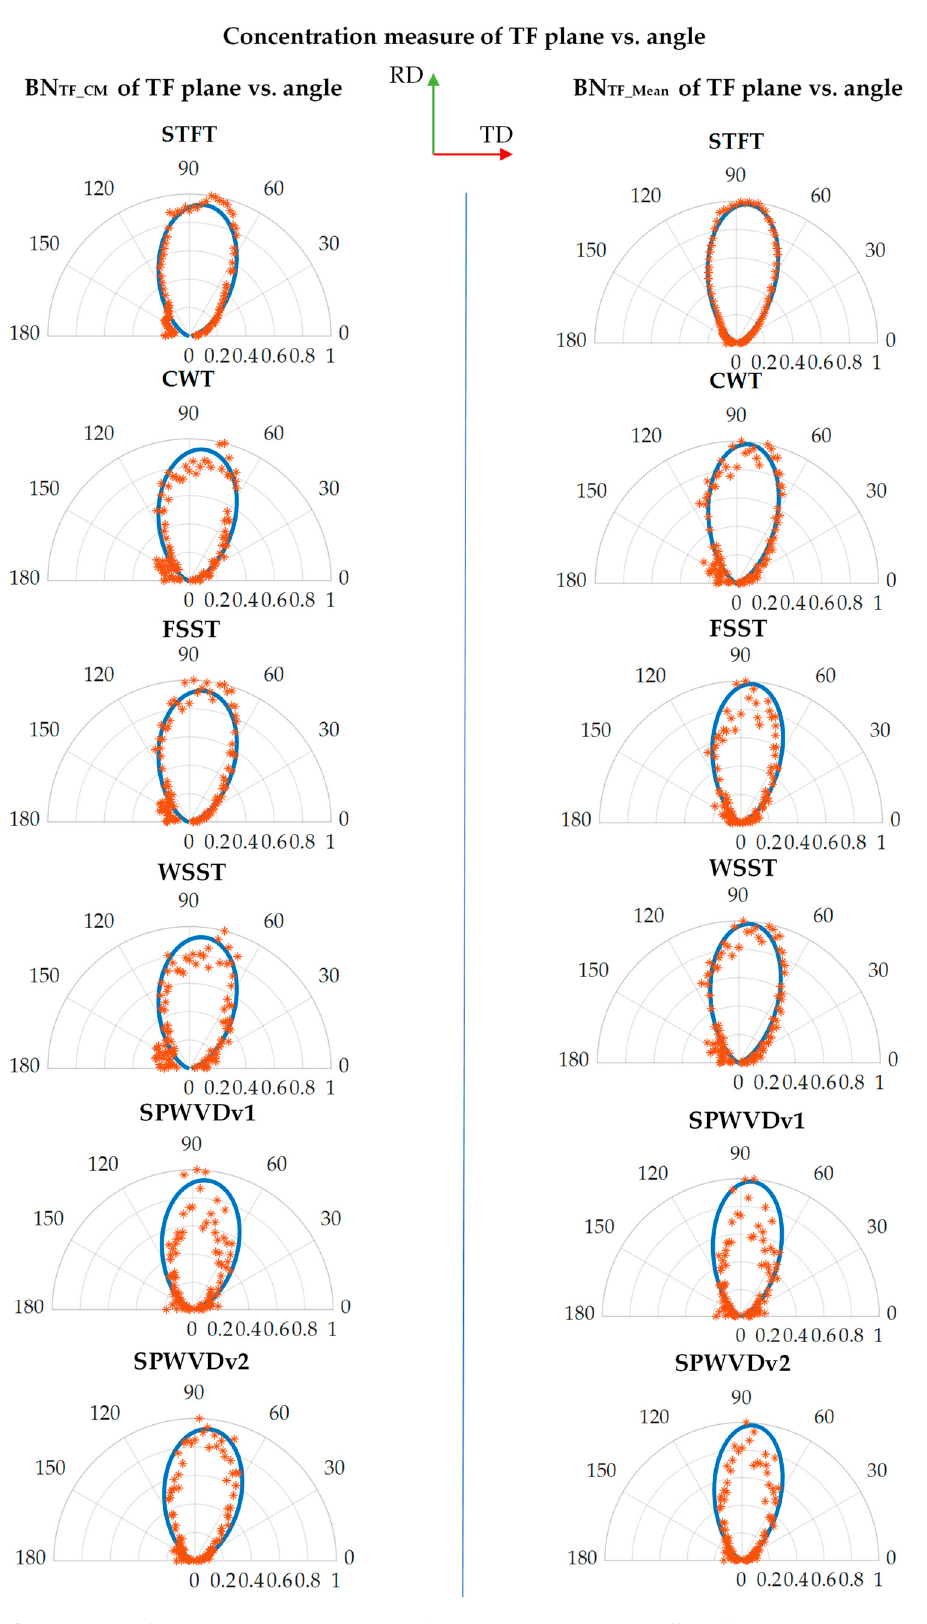
Figure 5. Plot of BN TF_CM and BN TF_MEAN parameters with approximation; RD—rolling direction, TD—transverse direction.